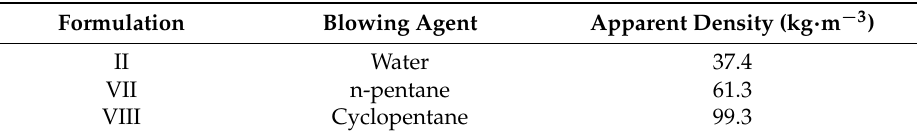
Table 2. Density values of foams with different blowing agents.